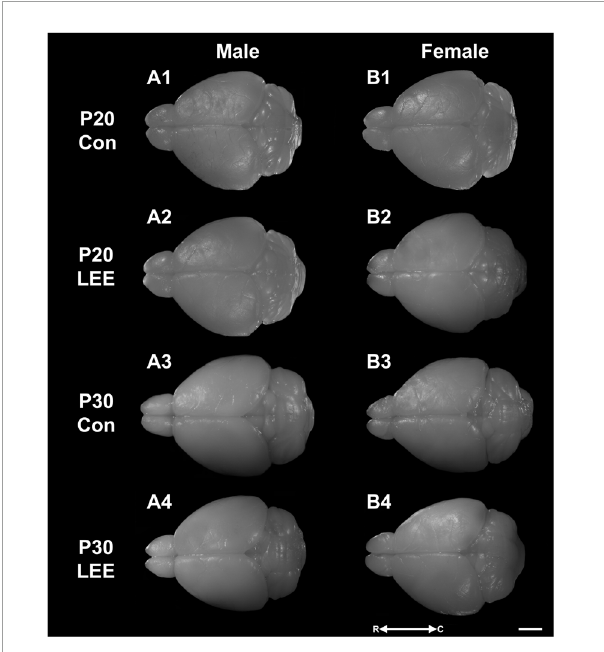
FIGURE4 Dorsal views. Representative images of perfused and extracted brains of male (A1–A4) and female (B1–B4) pups at P20 (A1,A2,B1,B2) and P30 (A3,A4,B3,B4) after dams were exposed to water (A1,B1,A3,B3) or EtOH (A2,B2,A4,B4) for 14 days. Images oriented rostral (R) to the left and caudal (C) to the right. Scale bar, 1 cm.